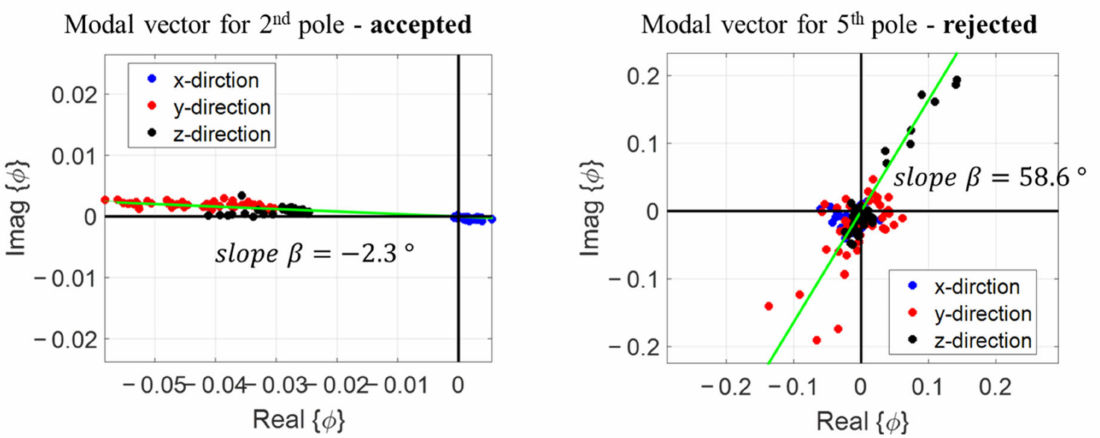
Figure 6. Modal vectors are represented in the complex plane to decide whether to accept or reject the